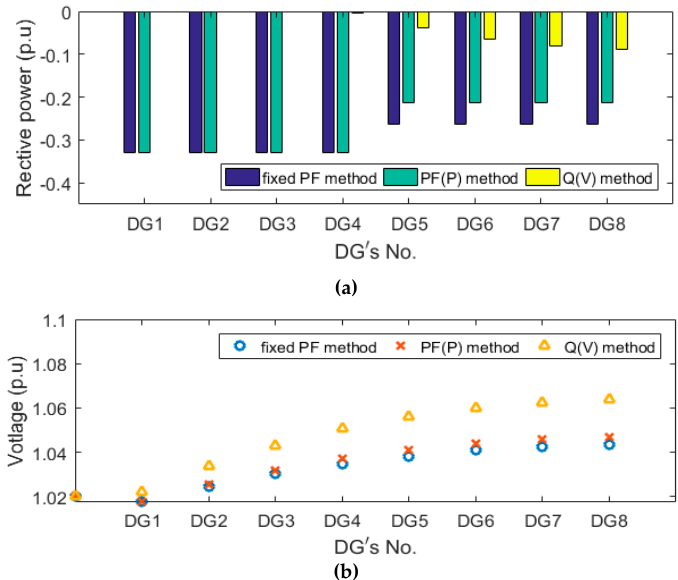
Figure 6. ( a ) Reactive power output; and ( b ) node voltage of distributed generators with different method when the output of each DG is set as shown in Figure 4 and set all loads to 0.3 p.u. of rated active power of